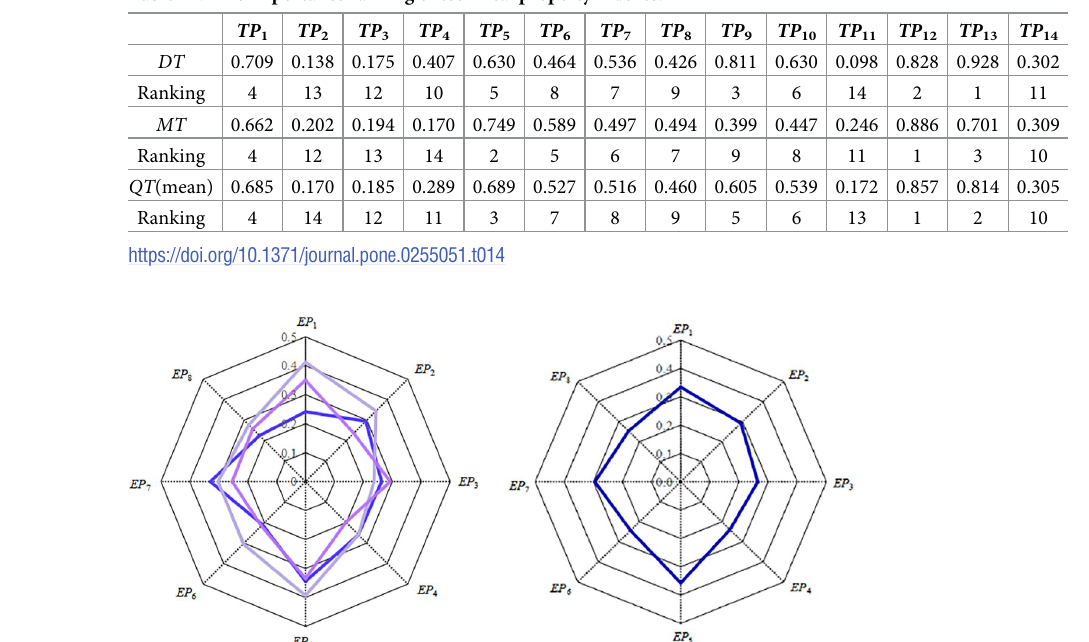
Table 14. The importance ranking of technical property indexes.